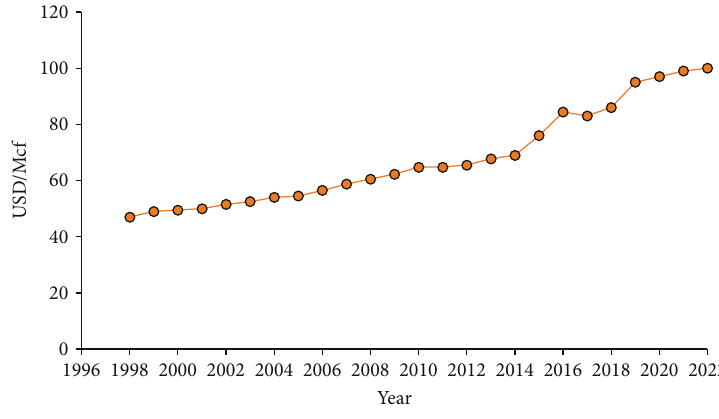
Figure 4: In-kind prices for crude helium in the U.S from the